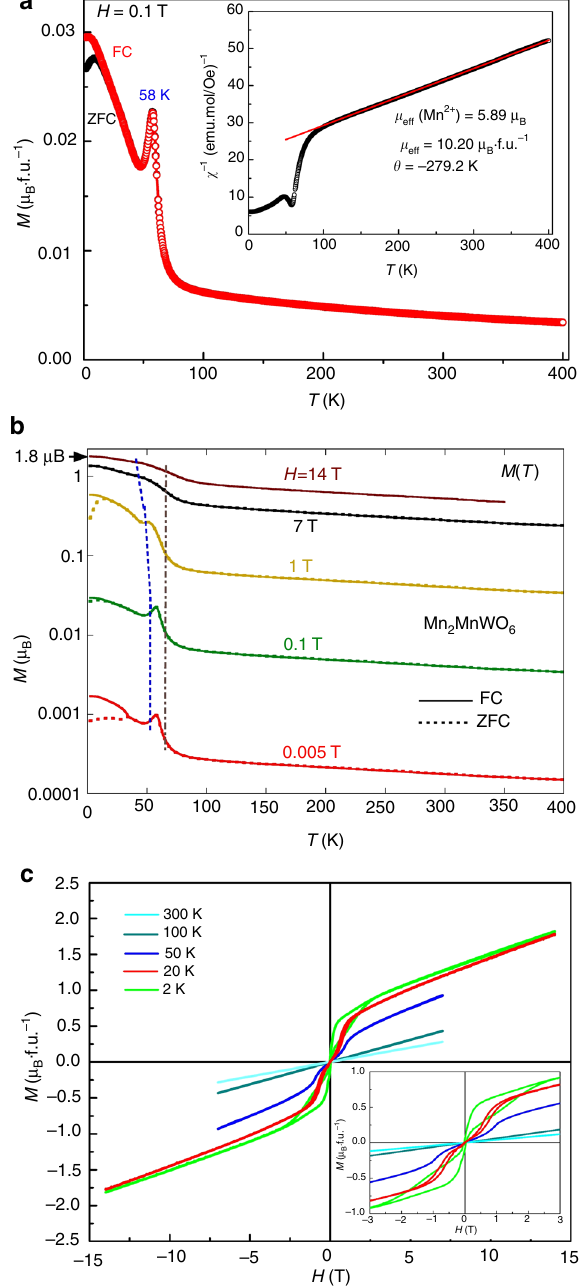
Fig. 2 Magnetic properties of Mn 2 MnWO 6 . a Thermal evolution of the ZFC and FC mode magnetization ( M ) and the reciprocal susceptibility (inset) of Mn 2 MnWO 6 measured with H = 0.1 T up to 400 K. b A logarithmic plot of the M ( T ) curves at a series of magnetic fi elds between 0.005 and 14 T. The dashed line highlights the evolution of AFM transition temperatures. The dash-dot line highlights the presence of local magnetic correlations near 60 K in all fi nite magnetic fi elds. c Isothermal magnetization curves of Mn 2 MnWO 6 measured at 2, 20, 50, 100, and 300 K between -14 and 14 T for 2 and 20 K; -7 and 7 T for 50, 100, and 300 K. Inset shows the curves between -3 and 3